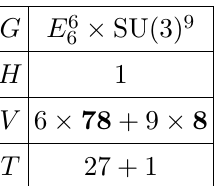
) conformal matter, illustrated 6 , E 6